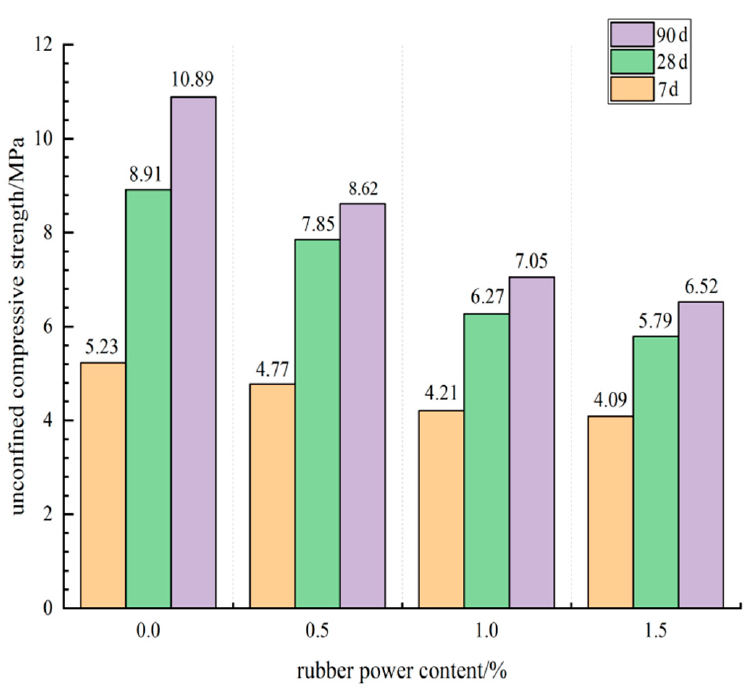
Figure 11. Effect curve of rubber powder content on unconfined compressive strength. It can be seen from Figure 11 that when the cement content and sodium gluconate content were certain, with the increase of the mass fraction of rubber powder in cement- stabilized macadam mixture, the unconfined compressive strength of water-stabilized macadam mixture decreased gradually at 7 days, 28 days, and 90 days. When the rub- ber powder content was 1.5%, the strength loss of cement-stabilized macadam mixture specimen was more obvious. For example, when the cement content was 5% and 0.06% sodium gluconate was added, the 7-day compressive strength of the specimen without rubber powder reached 5.23 MPa. When the mass content of rubber powder reached 1.5%, the 7-day compressive strength of the specimen only reached 4.09 MPa, which was 21.8% lower than that of the blank group without rubber powder. From the 28 d compressive strength results, the compressive strength of specimens without rubber powder reached 8.91 MPa. When the mass content of rubber powder reached 1.5%, the compressive strength of specimens only reached 5.79 MPa. Compared with the blank group specimens without rubber powder, the strength decreased by 35.0%. From the analysis of 90 d compressive strength results, the compressive strength of the blank group specimen reached 10.89 MPa. When the mass content of rubber powder reached 1% and 1.5%, the compressive strength of the specimen reached 7.05 MPa and 6.52 MPa, and the strength decreased by 35.3% and 40.1%, respectively. The strength loss was more obvious.